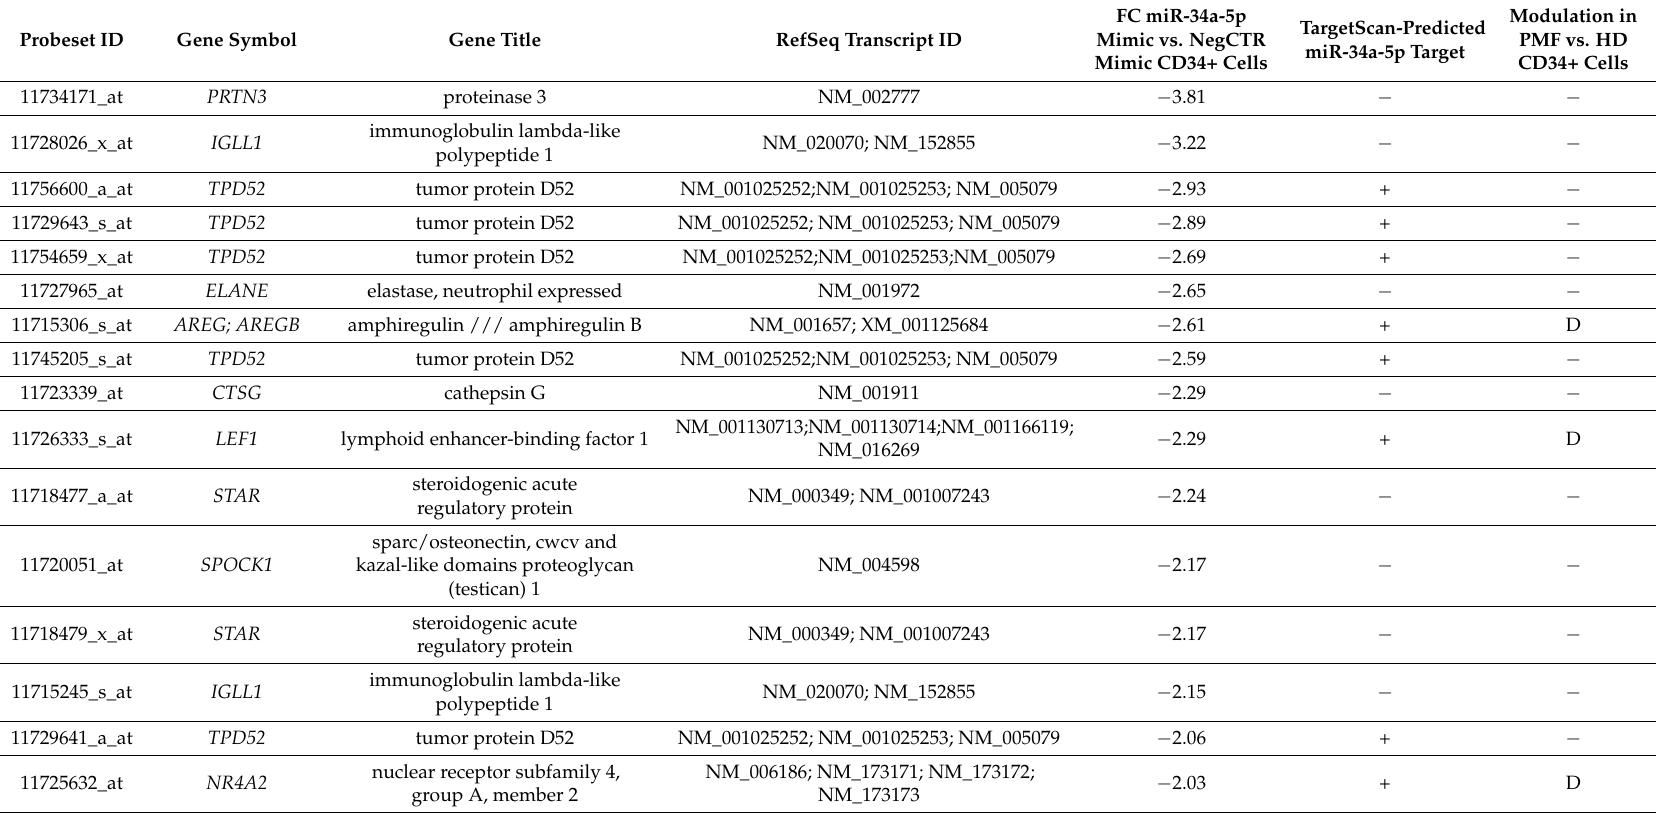
Table 1. Transcripts downregulated upon hsa-miR-34a-5p overexpression in CD34+